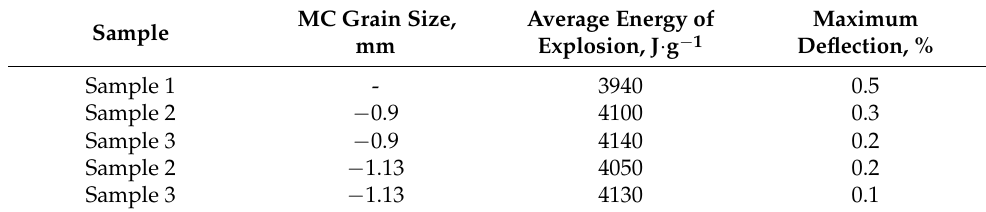
Table 6. Post-blast volume after 10 min, afterburning effect of the non-ideal explosive with a microstructure charcoal enhancer of − 90 μ m grain.